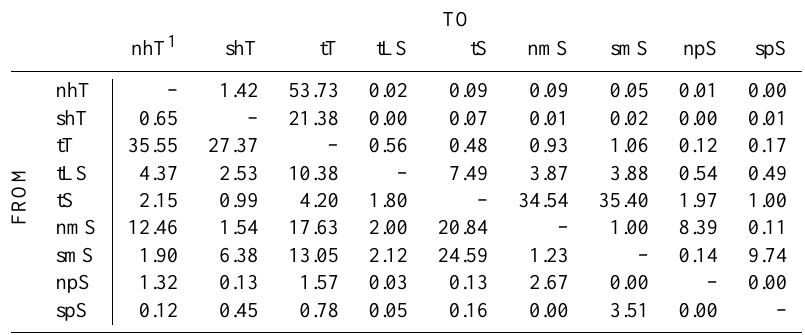
Fig. 9. Climatology (2000–2009) of annual mean ozone mass fluxes (10 10 kgyr − 1 ) (left) and air mass fluxes (10 16 kgyr − 1 ) (right). In the upper figure, the annual mean ozone budget of each region is shown, i.e. the total destruction ( D ), production ( P ) and net transport ( T ). In the troposphere, also the deposition (Dep) is listed separately. Values are rounded, i.e. mass fluxes shown as “0” are smaller than 0 . 5 × 10 10 /0 . 5 × 10 16 kgyr − 1 , respectively. Table 1. Annual ozone mass transport in 10 10 kgyr − 1 from each predefined region to each of the eight other